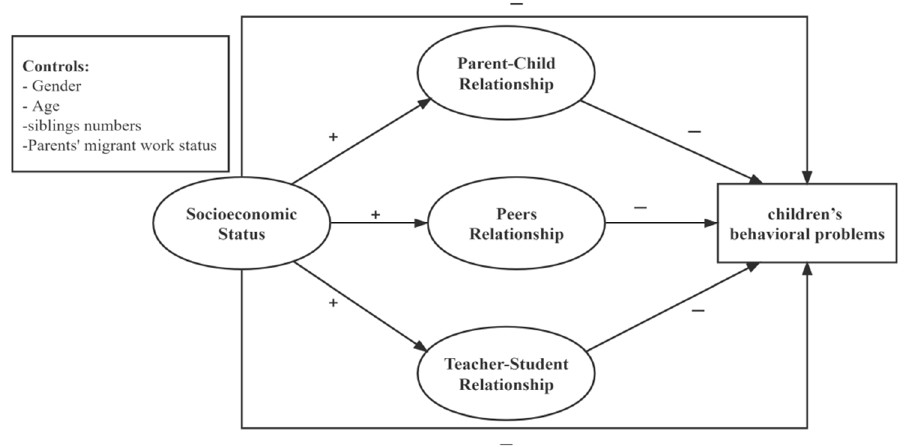
Figure 1. Conceptual framework.